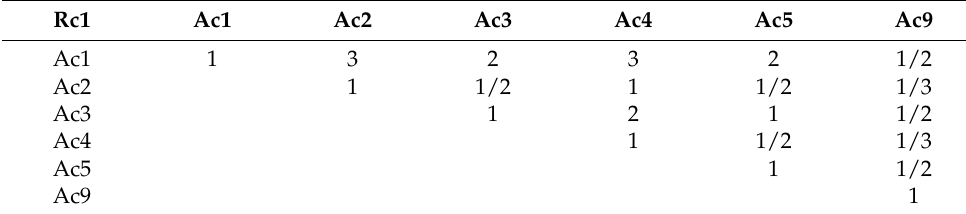
Table 4. Judgment matrix based on RC1 index.